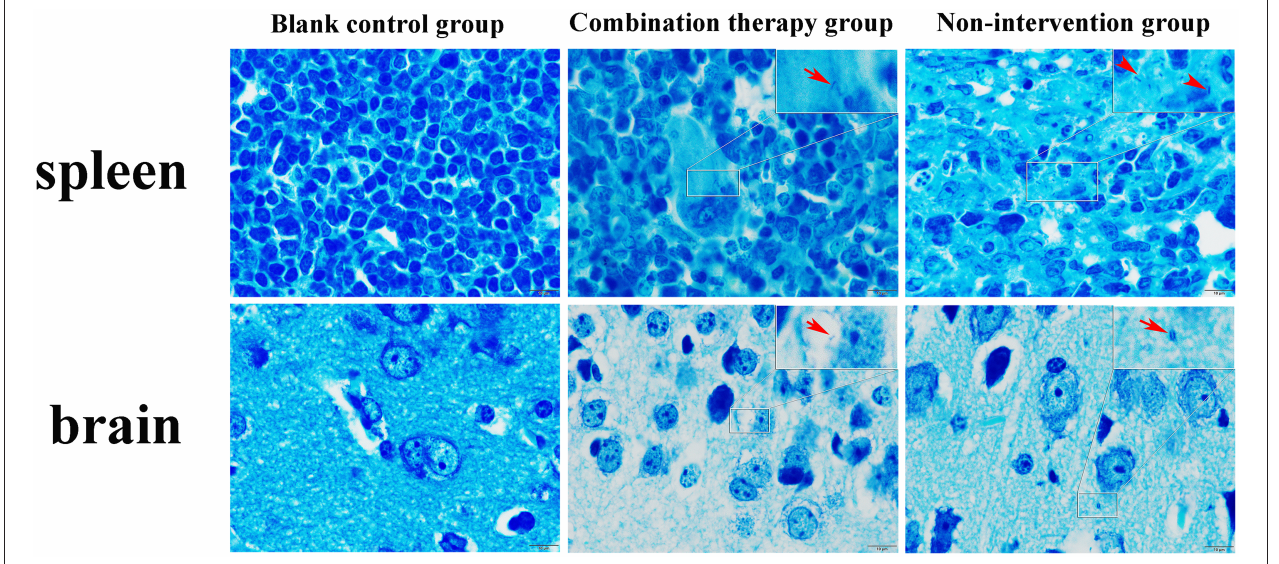
FIGURE 8 | Spleen bacterial load in the listeriosis model. (A) Blank control group. (B) . Toxic reaction group. (C) Penicillin G sodium treatment group. (D) Phage Therapy Group. (E) Combination Therapy Group. (F) Non-intervention group. The values are means and standard deviations (SD) ( n = 5). *C < 0.05. Each group vs. combination therapy group. * N < 0.05. Each group vs. non-intervention group.